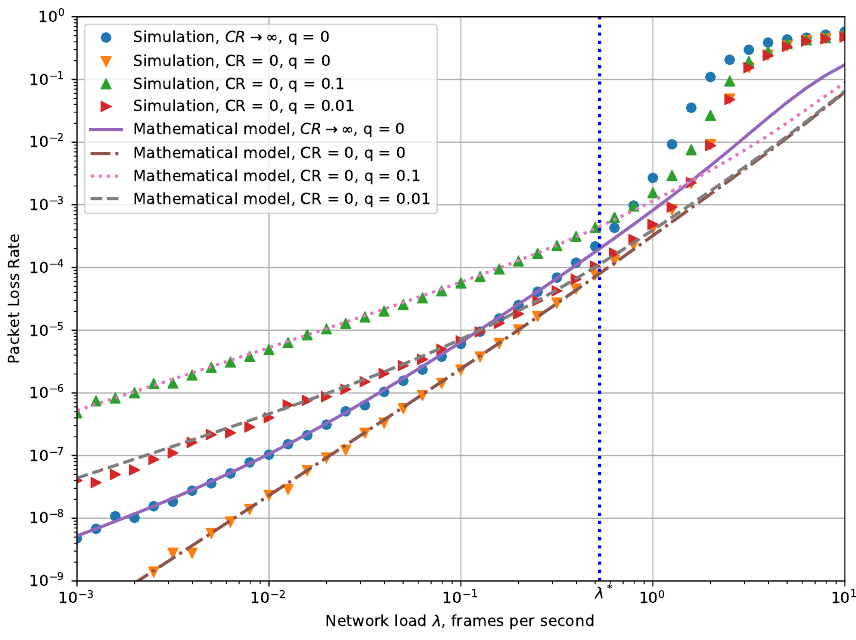
Figure 6. Dependency of packet loss ratio (PLR) on the cumulative network